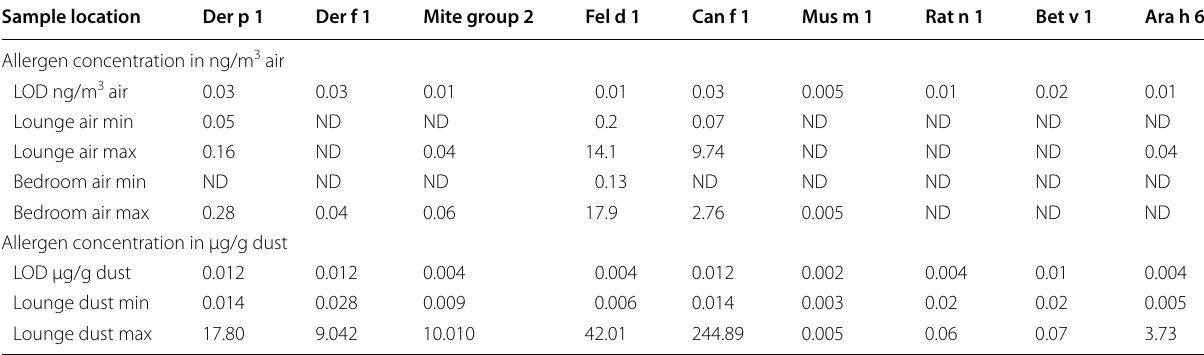
LOD limit of detection, ND not detectable above LOD in any of the homes